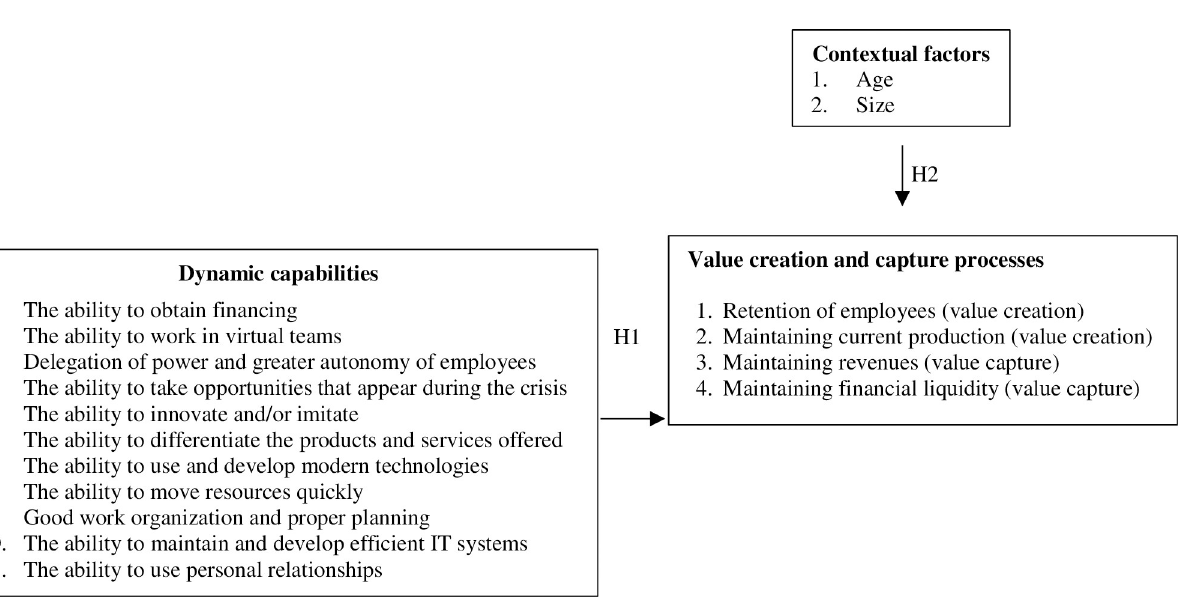
PLOS ONE | https://doi.org/10.1371/journal.pone.0252423 June 15,